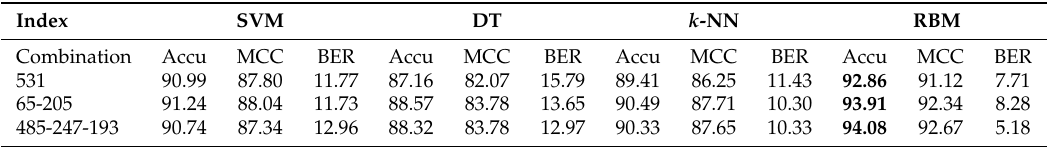
Table 13. Comparison of RBM results with conventional classification methods using one, two and three amino acid property index